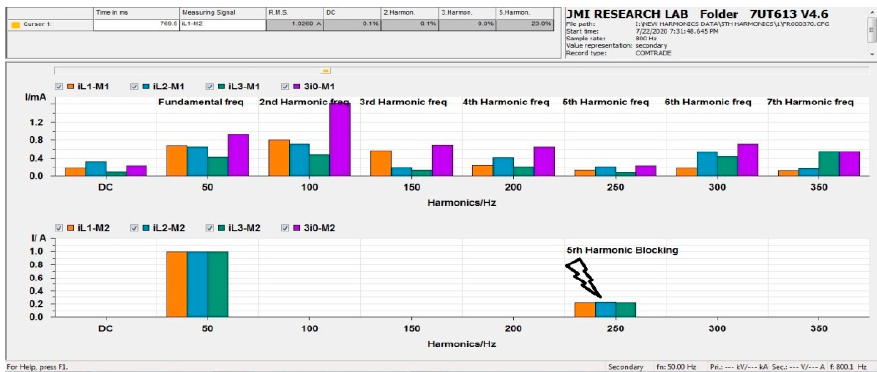
Figure 25. 5th HB at 1000 mA Rated current & 37% of Inrush current condition.